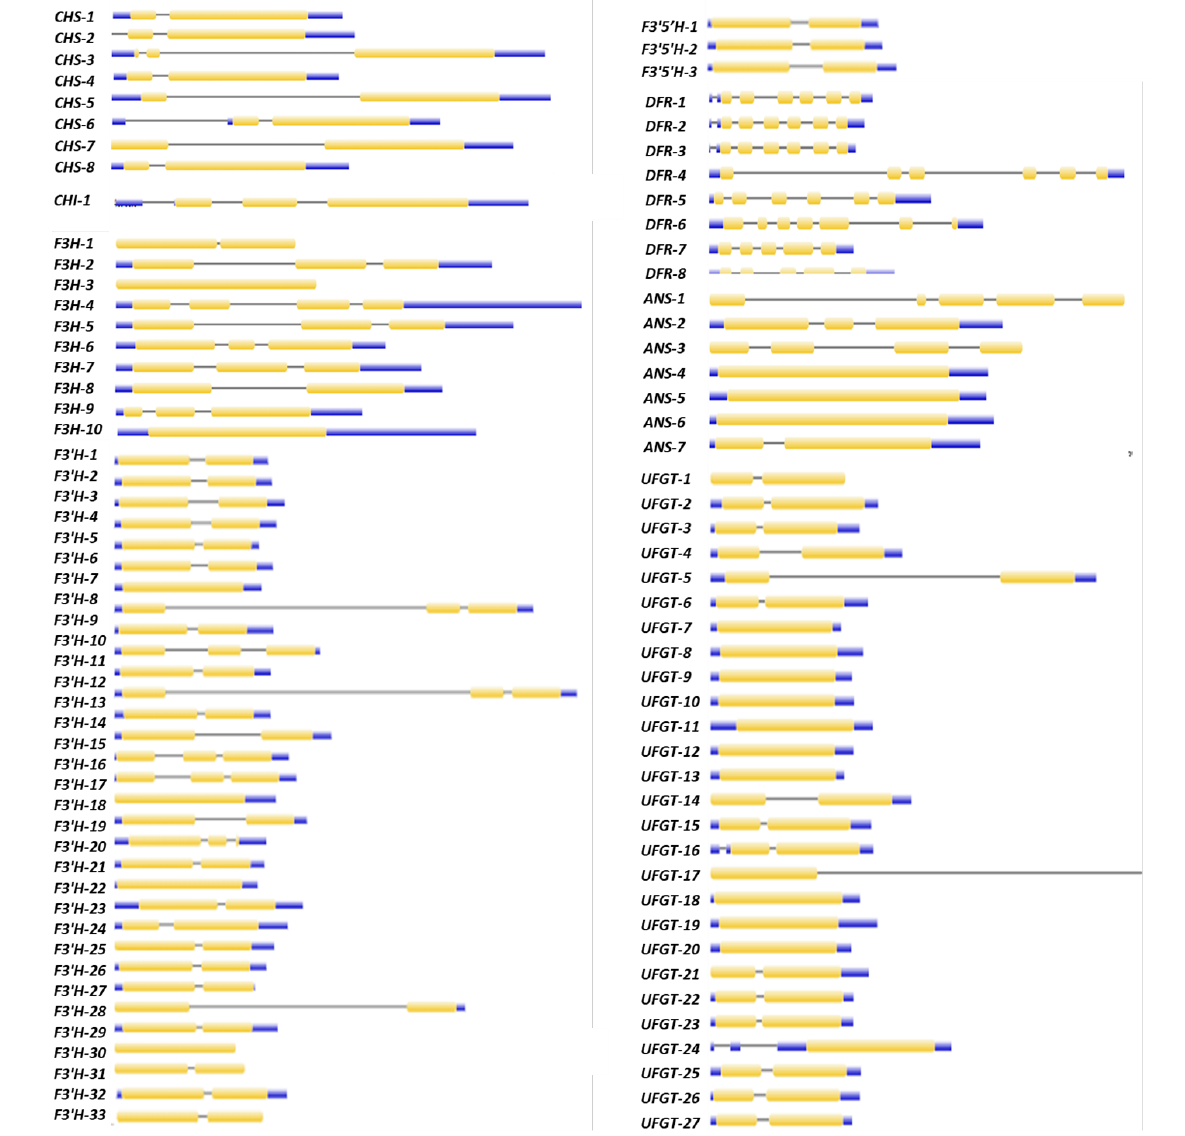
Figure 5. Exon – intron architecture of target genes. The gene structure was constructed by using the Gene Structure Display Server (GSDS). Exons are represented by yellow boxes and the introns are represented by the black lines.